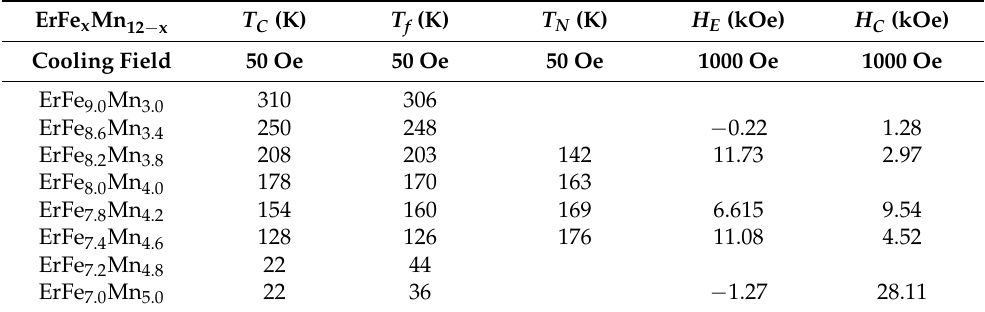
Table 2. Magnetic ordering temperature, exchange bias field and coercive force field of ErFe x Mn 12 − x (7.0 ≤ x ≤ 9.0) series alloys.